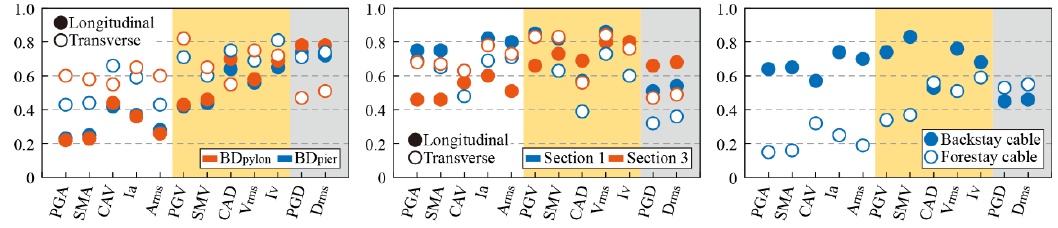
Figure 8. Determination coefficients for the regressions of various EDPs. The background colors denote the type of the IMs (white: acceleration-related; yellow: velocity-related; gray: displacement-related).